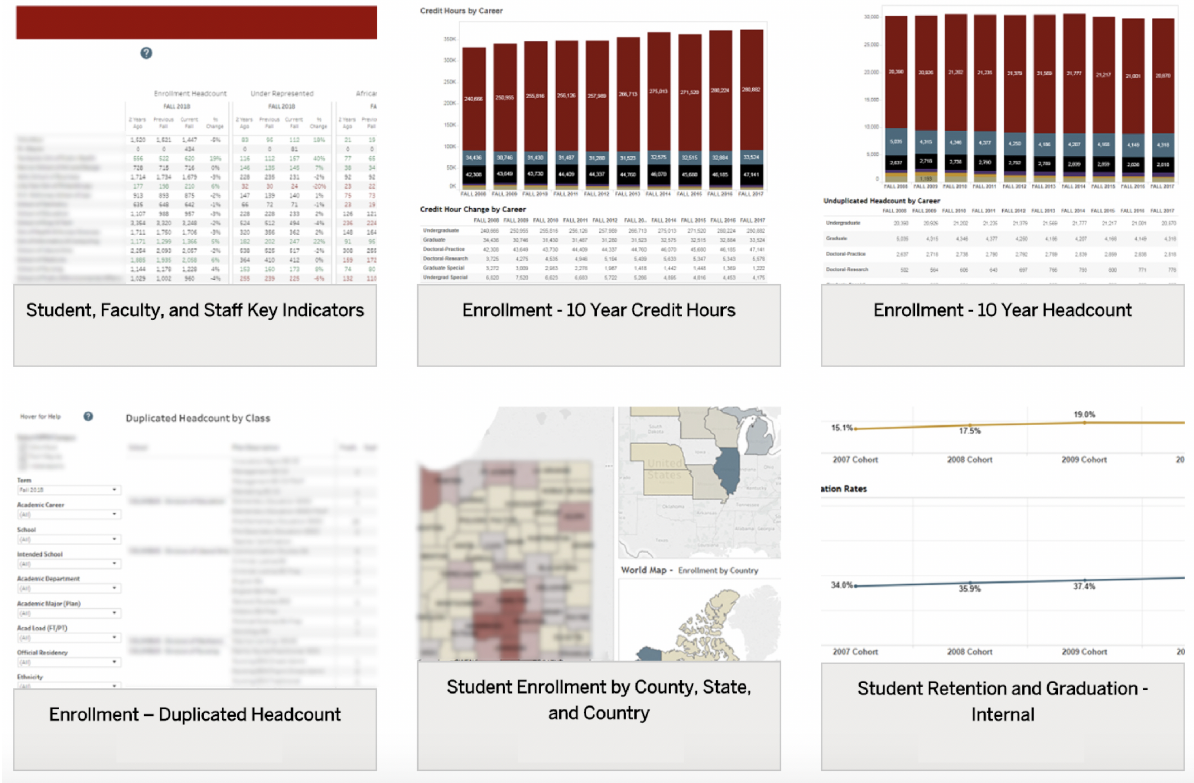
Figure 2. Another system available for querying data at a midwestern university: data visualizations available through